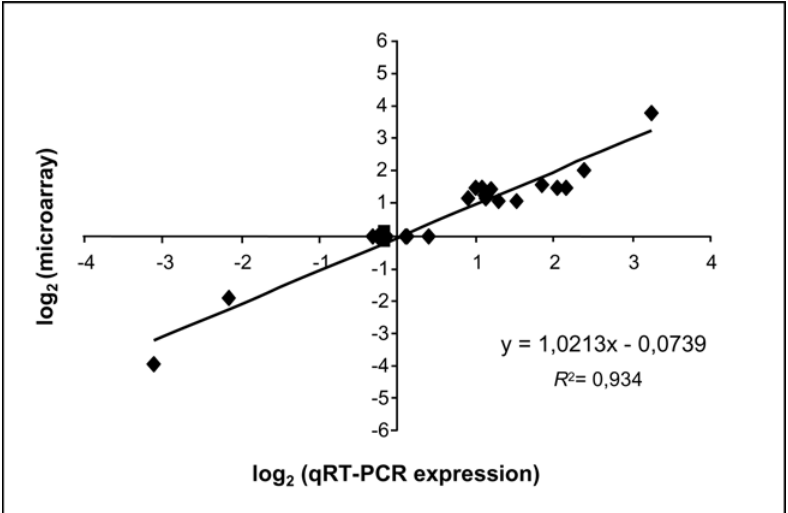
Figure 3. Validation of microarray-based expression profiles by qRT-PCR. The relative transcriptional levels for 16 genes were determined by real-time qRT-PCR using cDNA as template. Following normalization of data based on values measured with non regulated transcripts, the real- time qPCR log 2 values were plotted against the microarray log 2 values. The correlation coefficient (R 2 ) for comparison of the two datasets is of 0.934.